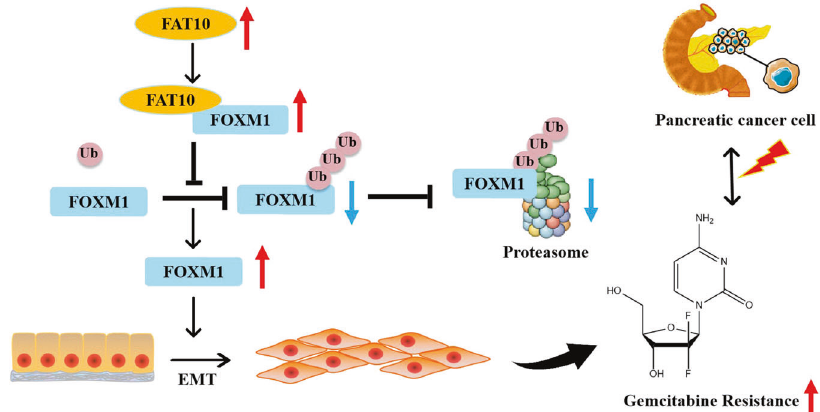
Fig. 8 Diagram of the regulatory mechanism of FAT10 promoting chemoresistance in PC. Proposed model by which FAT10 stabilizes the FOXM1 protein by competing with ubiquitin to bind FOXM1, thereby promoting EMT and chemotherapeutic resistance in PC